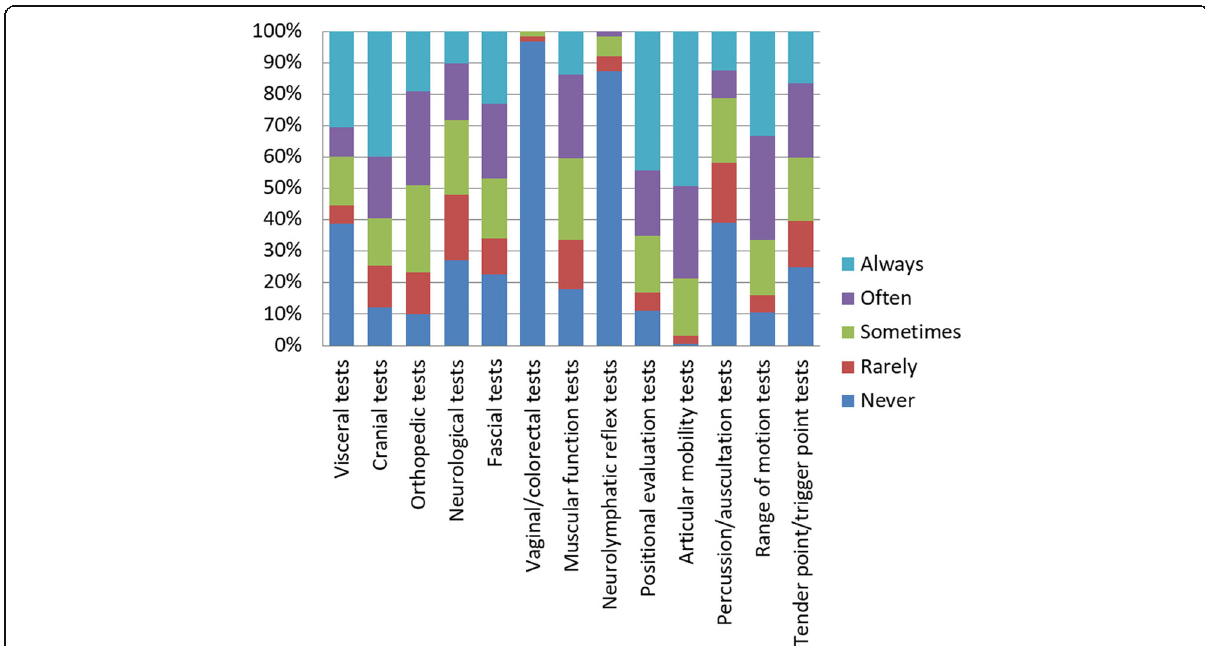
Fig. 4 « How often did you engaged self-directed practice on the following tests? » . Students had to choose one answer (Always, Often, Sometimes, Rarely, Never) for each of the 13 tests listed. The most common used test was ‘ articular mobility test ’ . The less used test was ‘ Neurolymphatic reflex tests ’